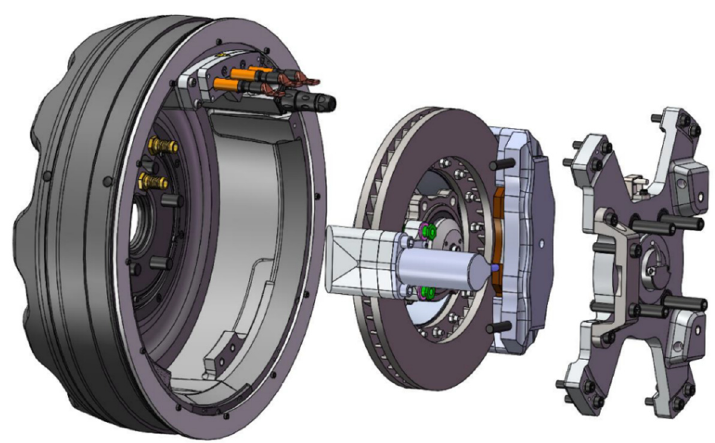
Figure 3. 3D model of theL1500 in-wheel machines used with brake assembly (replaced by Brembo EMB caliper) and knuckle mount.